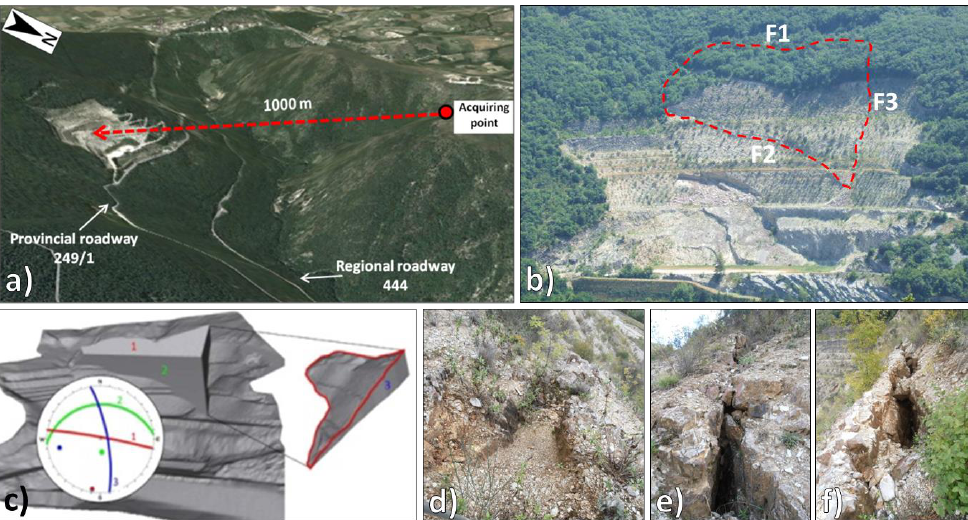
Figure 9. Thermographic survey installation point ( a ); view of the quarry front: in red a rough delimitation of the unstable wedge ( b ); TLS 3D representation of the sliding block and stereographic projection of the main planes delimiting it ( c ), after [68]; pictures of the lateral fracture pattern (F3) from bottom ( d ) to topmost sectors ( e , f ).